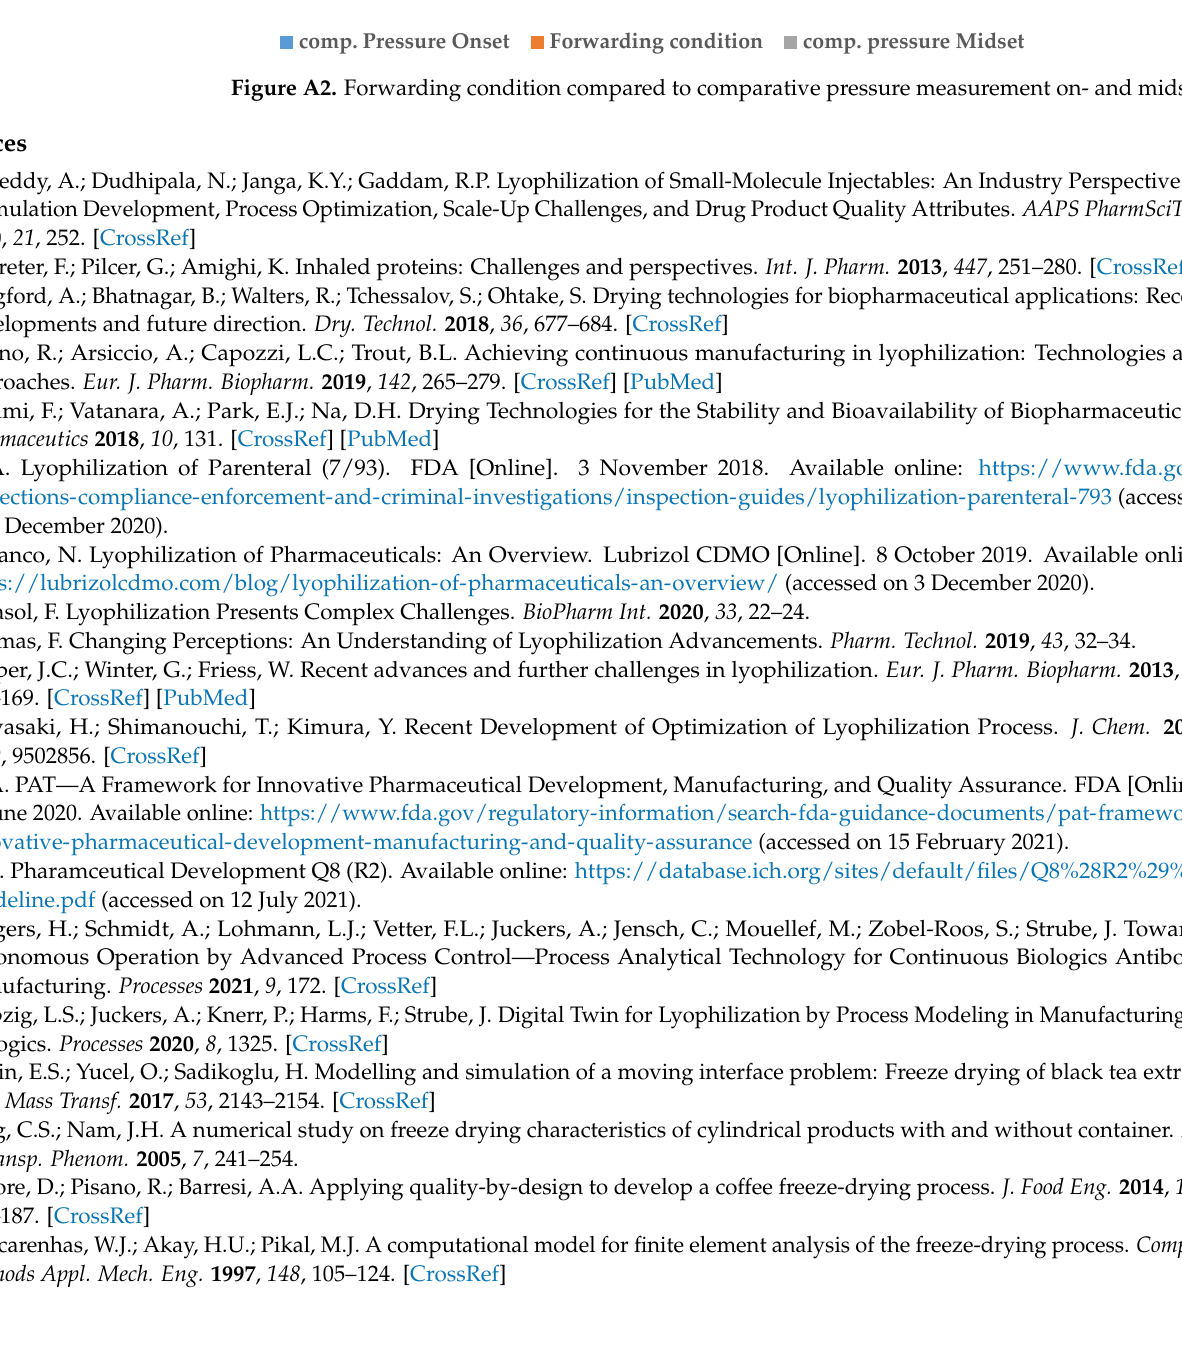
Figure A2. Forwarding condition compared to comparative pressure measurement on- and midset.